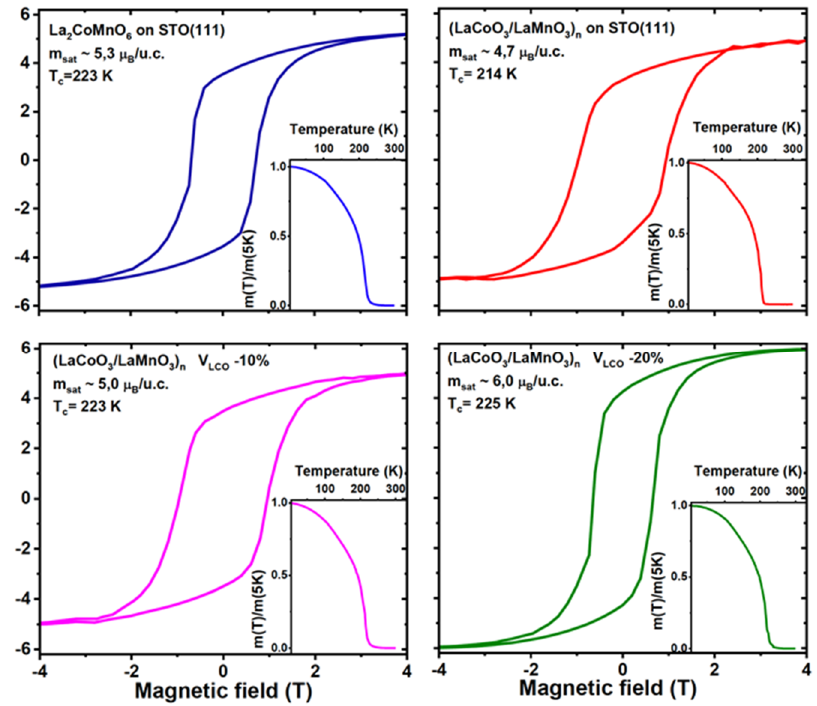
Figure 9. Magnetization m(B) at 5 K and m(T) at 1000 Oe (insert) of LCMO SoA (blue), LCO/LMO SL: L1(red), L2 (magenta), and L3 (green).